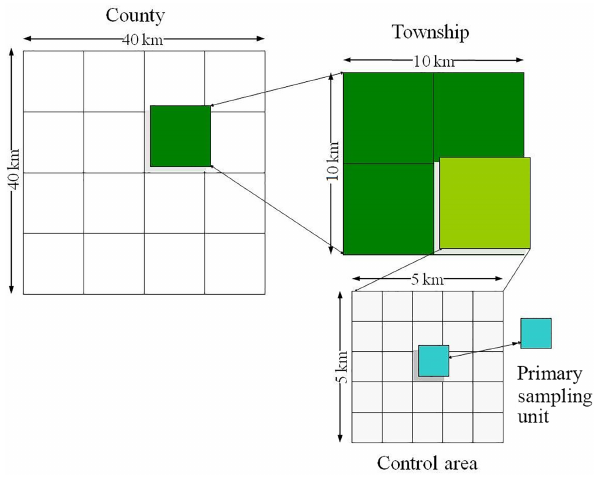
Figure 2. Schematic of sampling strategy for the fourth census on soil erosion in China.